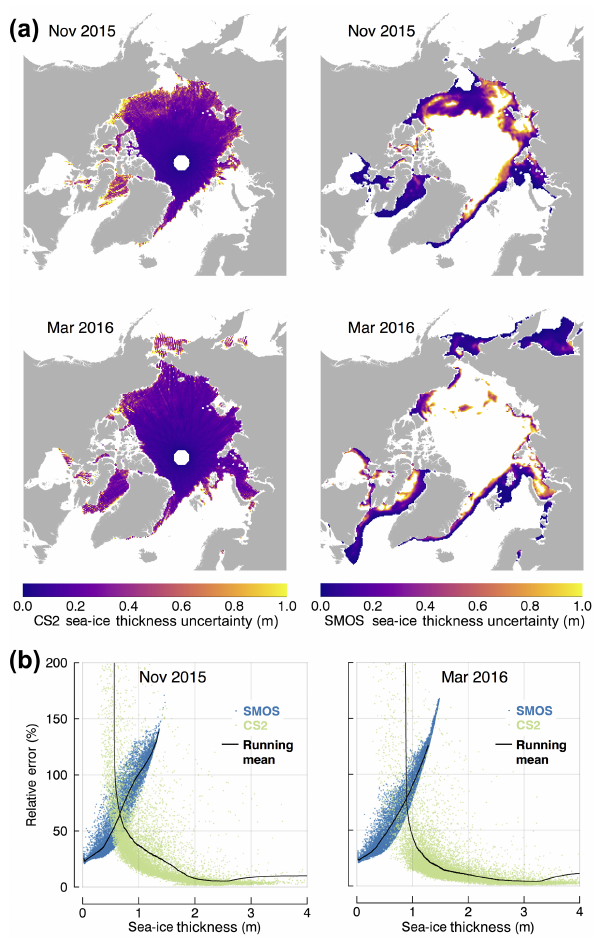
Figure 2. (a) Typical monthly sea-ice thickness uncertainty maps of the CryoSat-2 and SMOS retrievals from November 2015 and March 2016. The SMOS thickness uncertainty is masked where un- certainty is > 1m. (b) Relative uncertainties from November 2015 and March